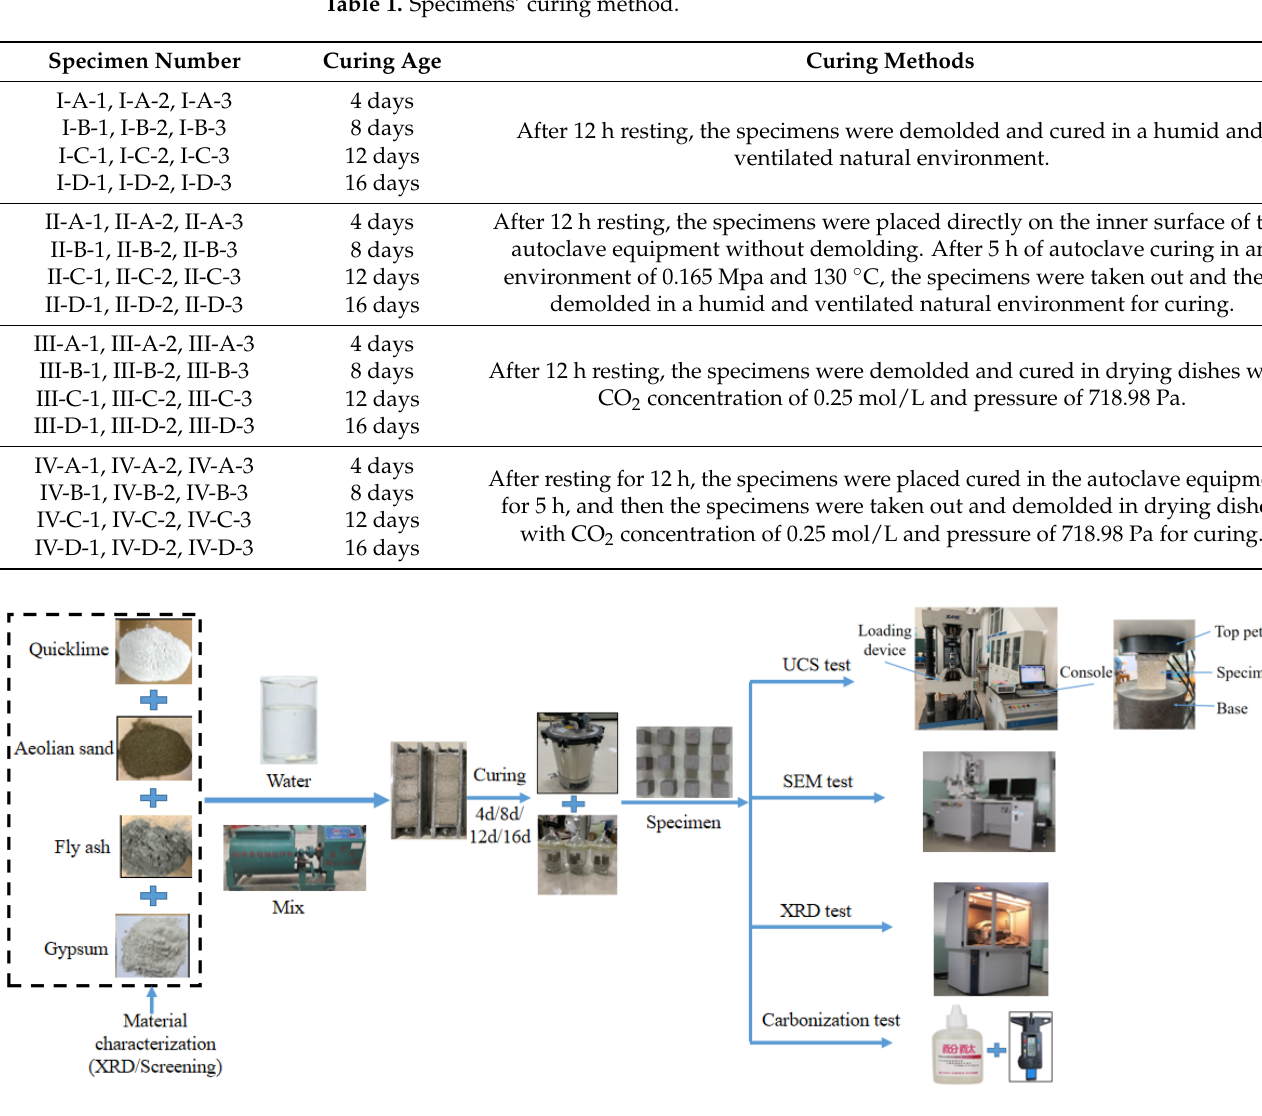
Figure 4. Experimental process. Here, SEM indicates scanning electron microscope.